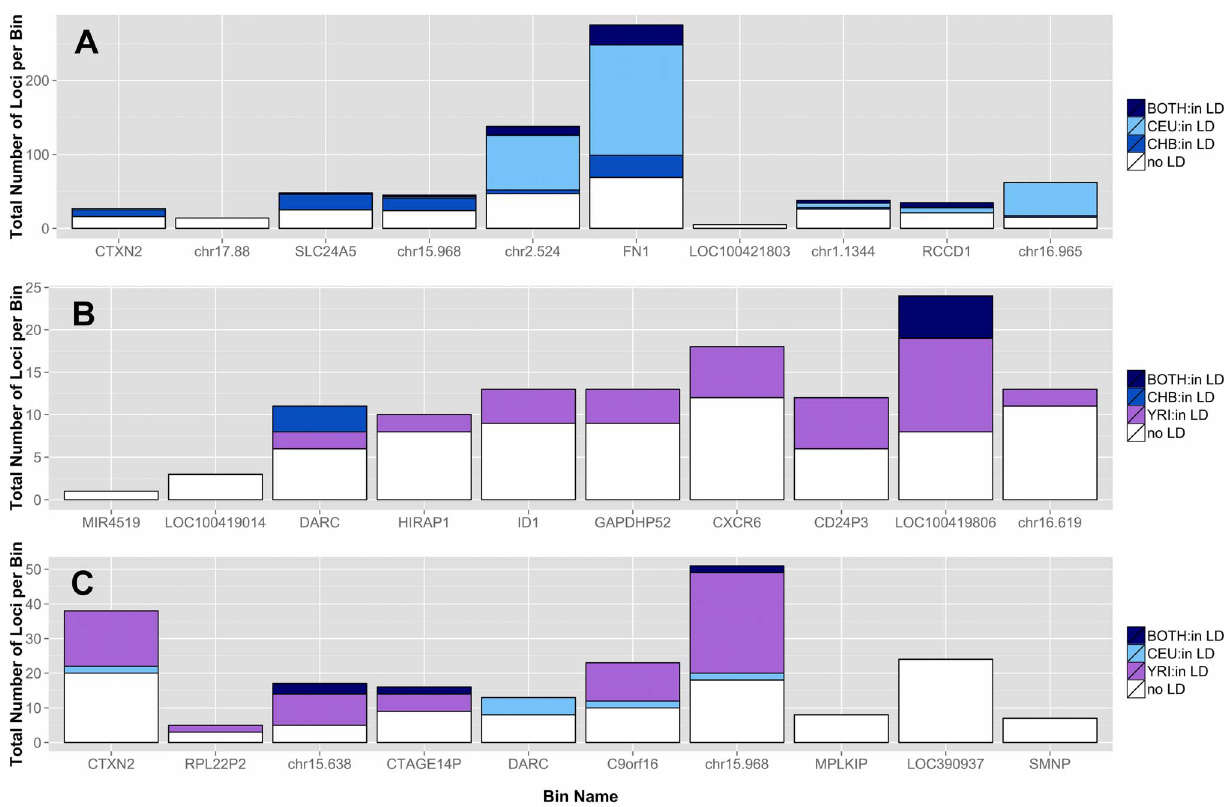
Figure 7. Proportion of loci in top bins in high LD with other variants in the same bin in A) CEU-CHB, B) CHB-YRI, and C) CEU-YRI population gene feature comparisons. Each bar represents a gene or intergenic bin. For a particular population comparison (A–C), the total height of the bar corresponds to the number of loci in that bin. The shades of blue and purple correspond to loci with r 2 LD values greater than 0.3 for a specific population shown in the legend. The variant can be in LD in one population, the other population, or both (described in each legend). Almost all of the low frequency loci in LD had r 2 values of approximately 0.5 or 1, corresponding to almost perfect LD. The white space corresponds to loci in the bin with LD values less than 0.3. The top bins are therefore, mostly composed of independent loci.